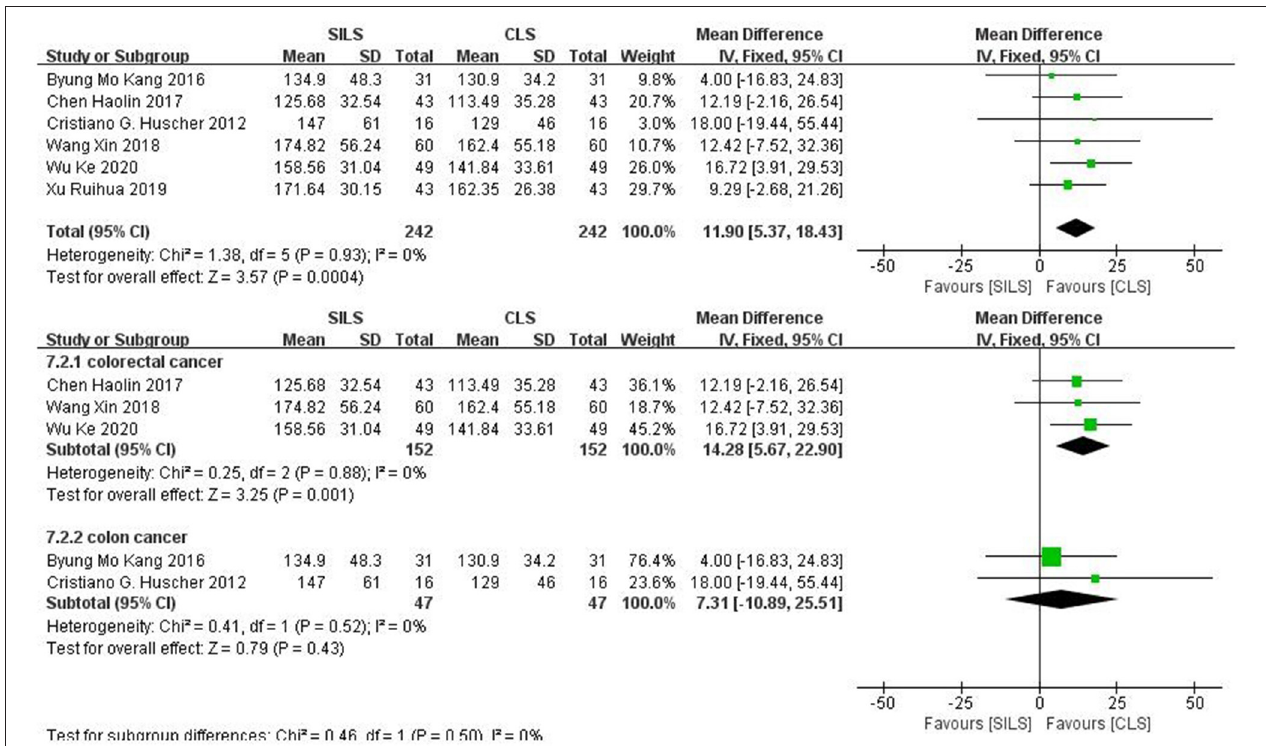
FIGURE 8 | Meta-analysis of operation time. SILS, single-incision laparoscopic surgery; CLS, conventional laparoscopic surgery.